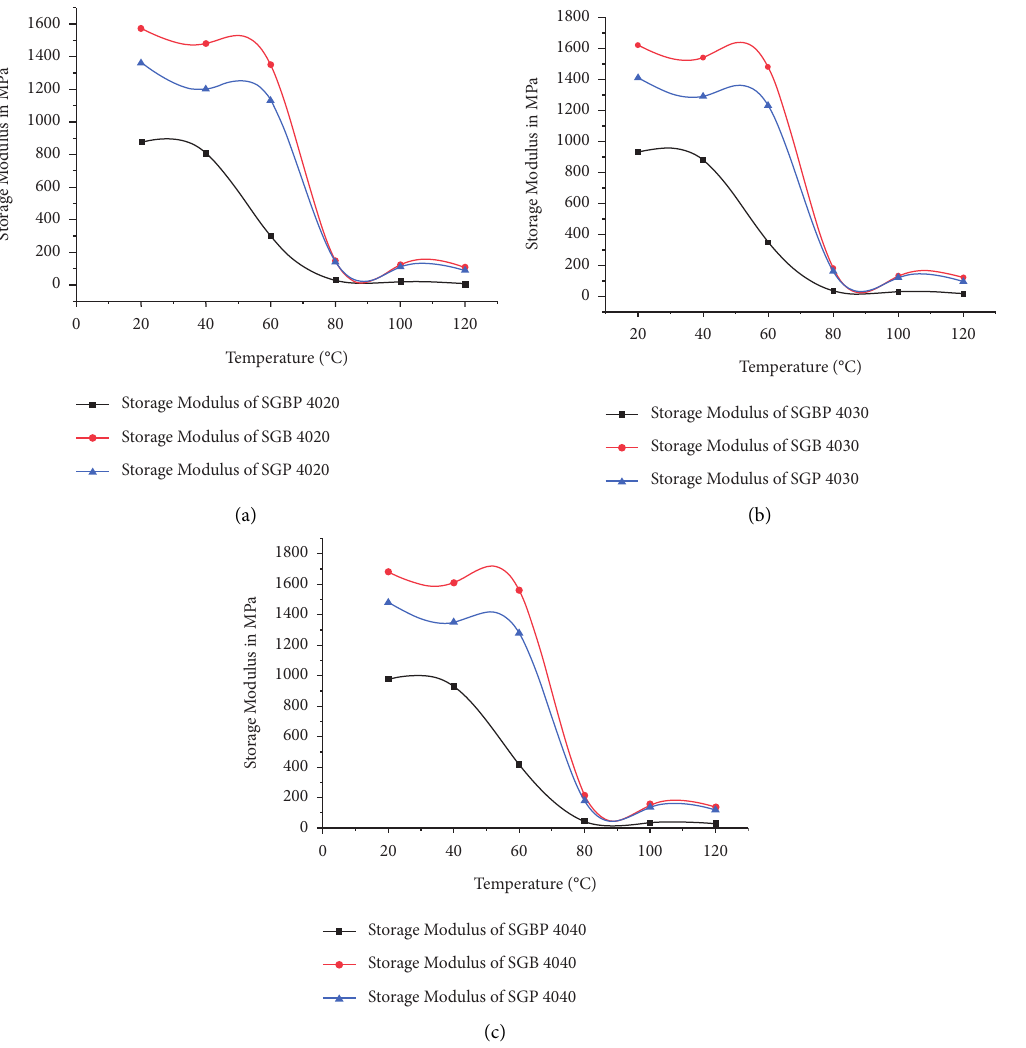
Figure 6: Graphical representation of storage modulus of sample at 40% fiber volume sample at (a) 20cm fiber length, (b) 30cm fiber length, and (c) 40cm fiber length.